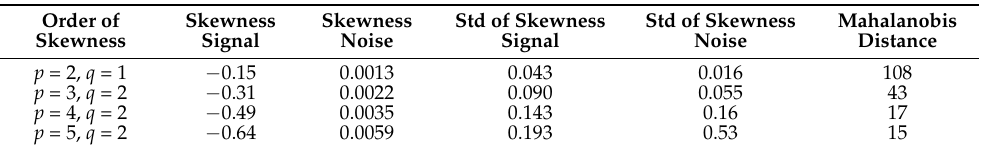
Table 4. Mahalanobis distance between the estimates of moments A p 1 q 1 and A p 2 q 2 characterizing the skewness of signal and noise.